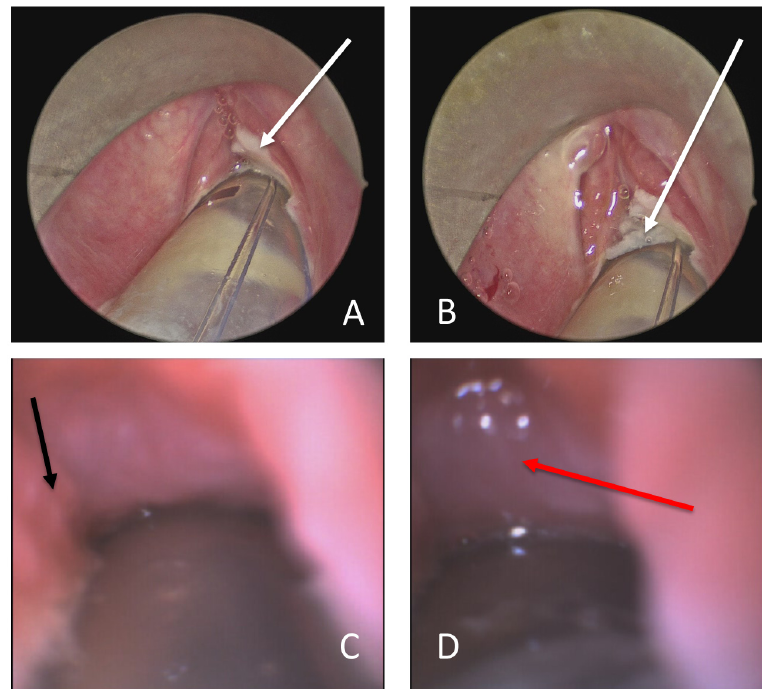
Figure 4. Case 2 glottis images. ( A ) View of supraglottis showing ulcerated glottis. ( B ) Glottis showing sparing of false cords, but profound glottic oedema and glottic and subglottic ulceration. ( C ) Flexible bronchoscopy via the anterior commissure shows subglottic oedema and granulation tissue (black arrow). ( D ) Oedematous mucosa prevents flexible bronchoscopy beyond the third tracheal ring. White arrows indicate areas of ulceration, black arrow granulation tissue and red arrow tracheal